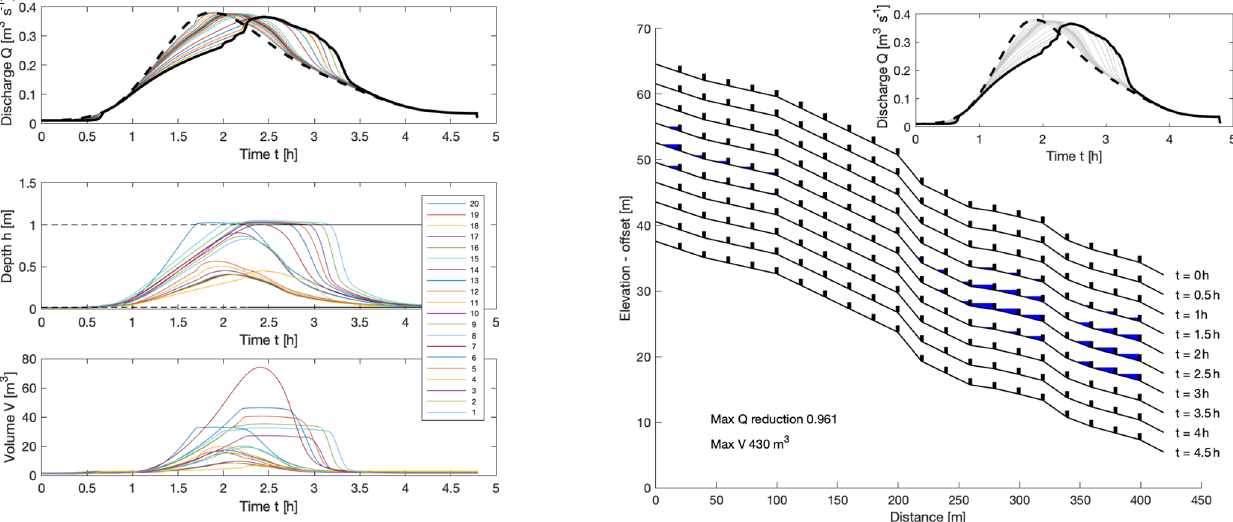
Figure 13. Model run with more leaky dams. The reduction peak discharge is 96% of the inflow, and the maximum volume stored is 430m 3